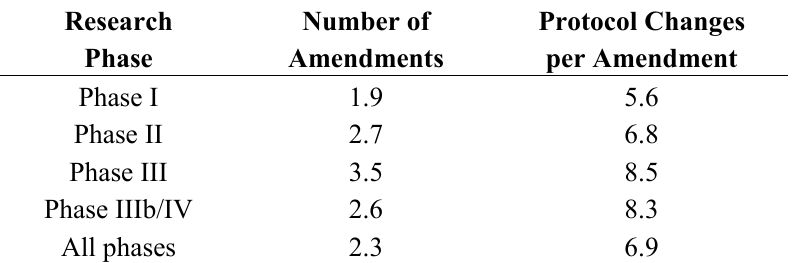
Table 3. Mean Number of Amendments and Changes per Amendment per Protocol by